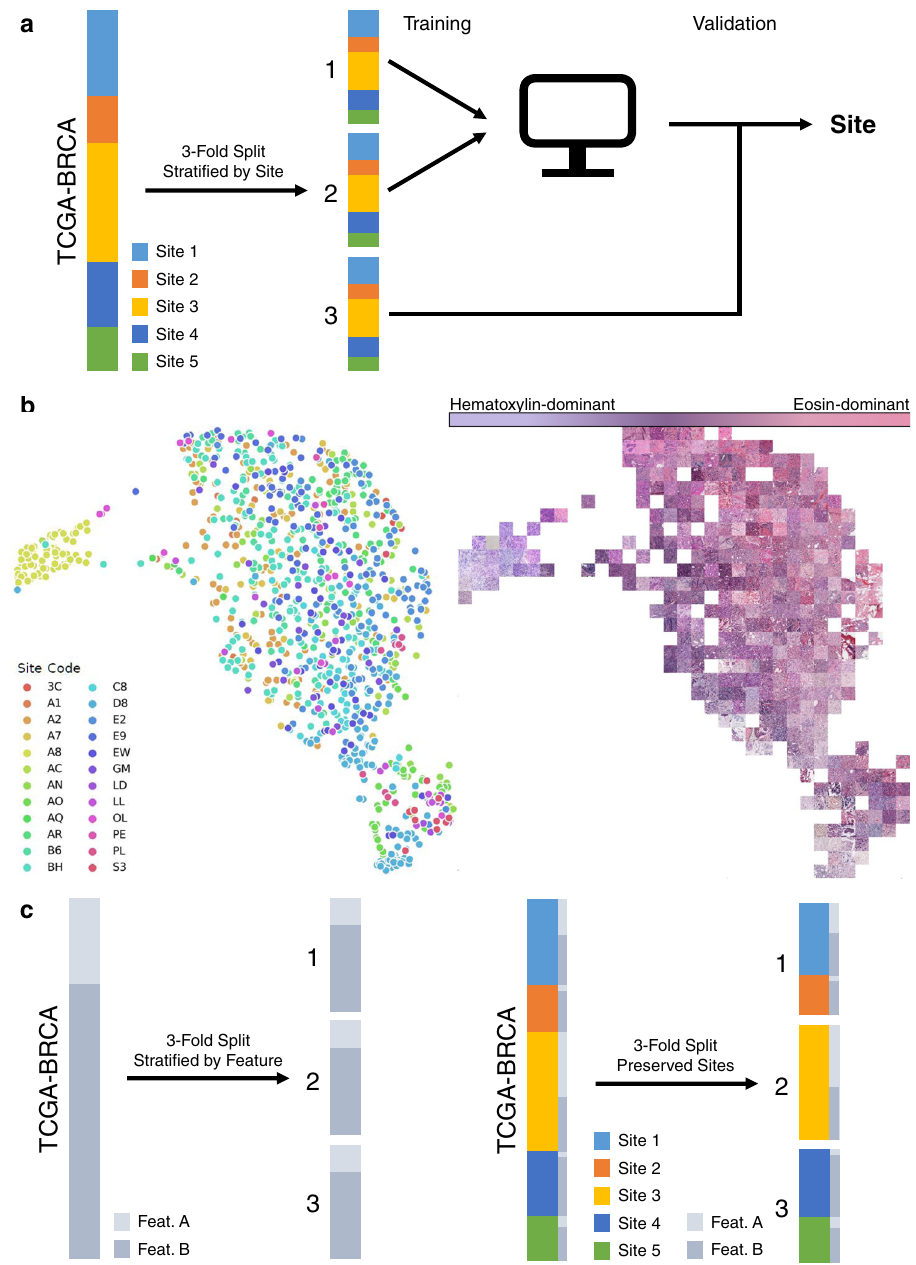
Fig. 5 Model development for the site and feature prediction for patients in TCGA. a To predict tissue submitting site, data is split into threefolds, with each site represented equally in all folds. Cross-validation is then performed, where a model is trained on two of the datasets and performance is assessed on the third dataset. This process is repeated threefold for an averaged performance metric. b UMAP representation of fi nal activation weight vector of the model trained to recognize submitting site in TCGA-BRCA ( n = 1006 slides). Each point on the left fi gure represents the centroid tile from a single slide. The nearest tile to each UMAP coordinate is visualized on the right, demonstrating a clear gradient from tiles that demonstrate predominant hematoxylin staining to those demonstrating predominant eosin. c We assess the impact of including slides from a tissue submitting site within both the training and validation sets on the prediction of a variety of clinical, genomic, and demographic features, using two methods of generating folds for cross-validation. First, we split the data into threefolds, stratifying by the feature of interest, irrespective of site. For a comparator, we split the data into threefolds where each site is isolated into a single fold, with the secondary objective of equalizing the ratio of features in each